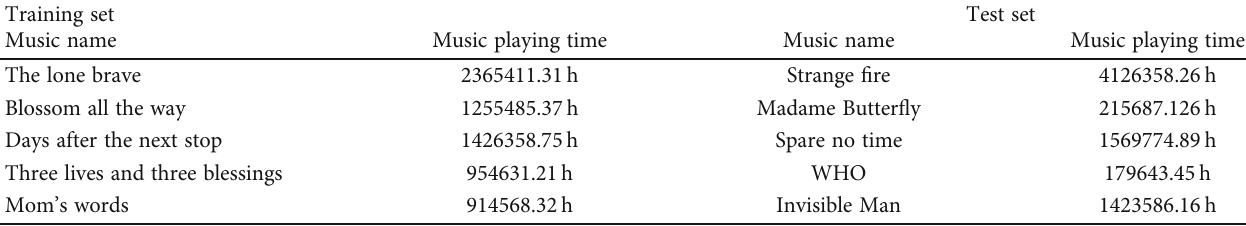
Table 2: Partial dataset trained in CNN model.